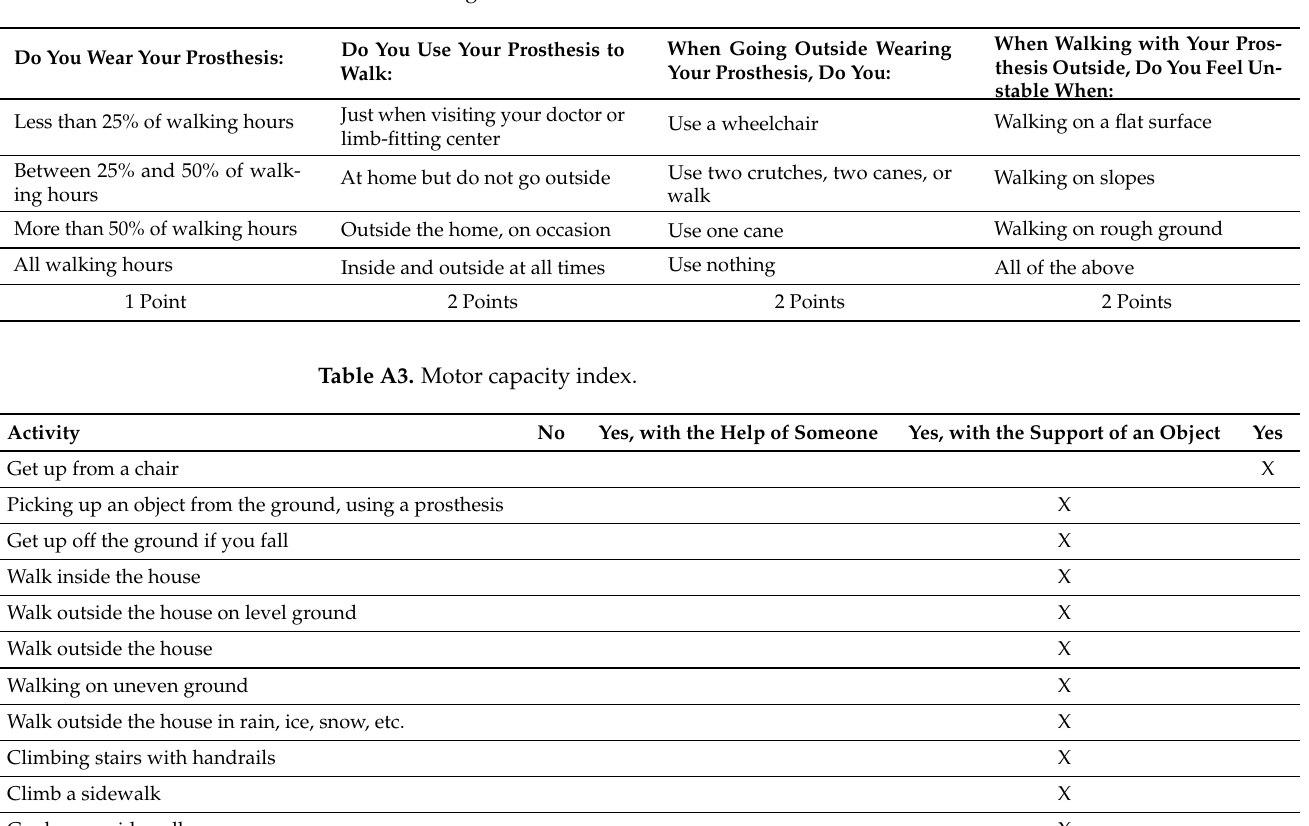
Table A2. Houghton instrument.